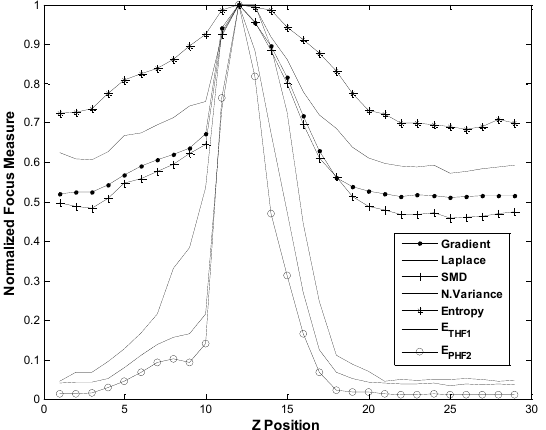
Figure 5. Comparisons of focus measures by wavelet-entropy E THF 1 , E PHF 2 and other common focus functions (SNR of test image = 26 ± 0.2 dB ).